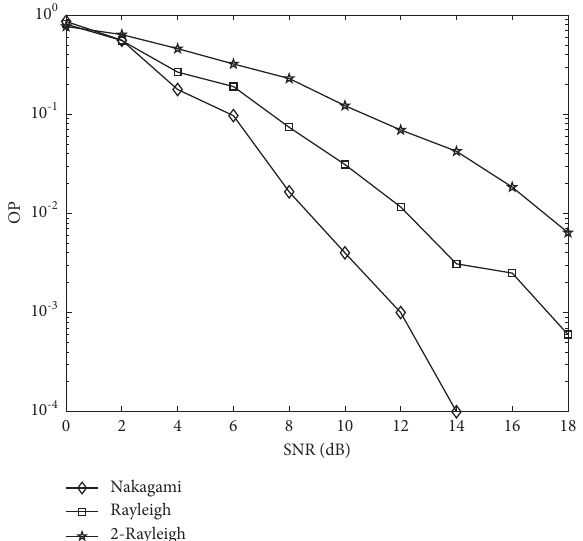
Figure 6: The OP performance comparison with different channel